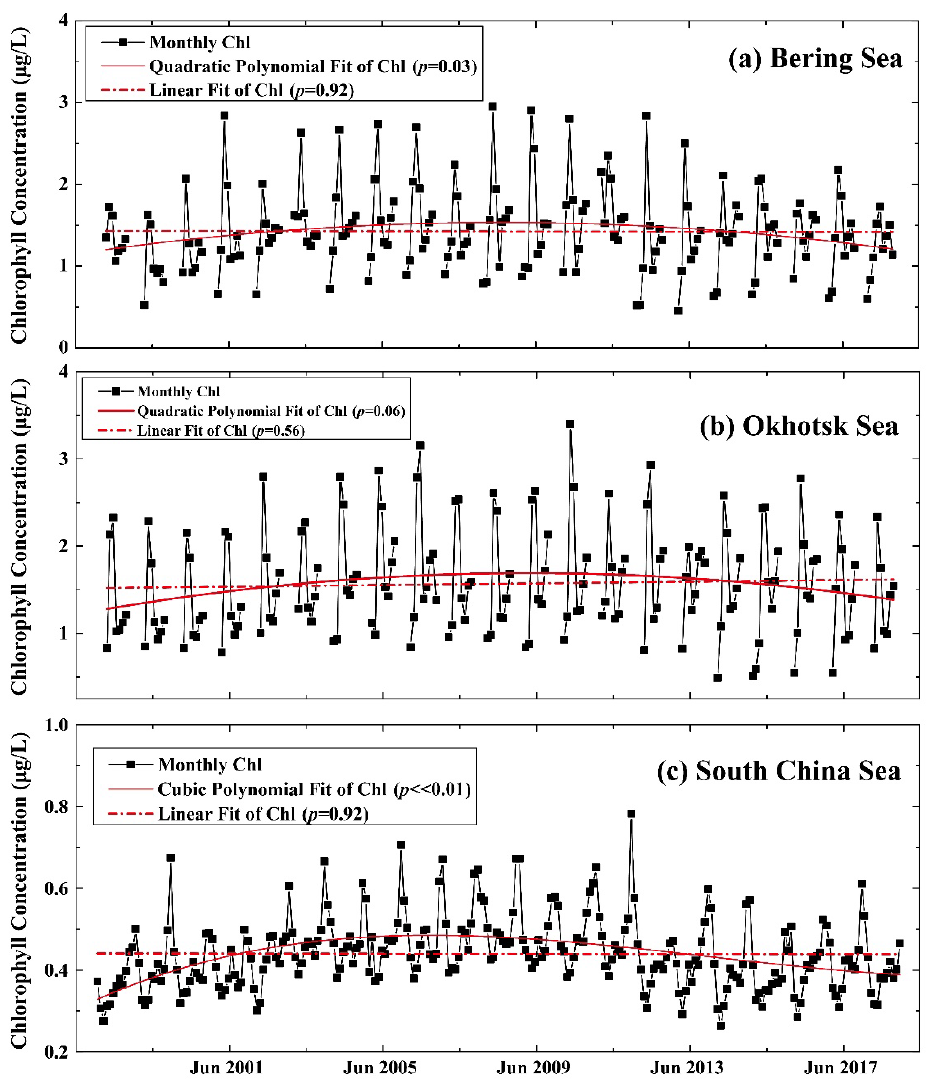
Figure 5. Time series of chlorophyll concentration in the ( a ) Bering, ( b ) Okhotsk, and ( c ) South China Seas during 1998–2018. Table 2. Changing rate and statistical information of Chl during different periods.